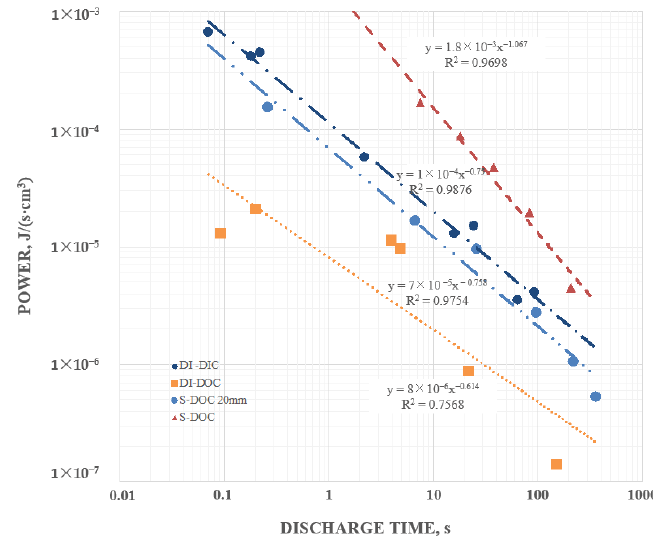
Figure 8. Increases with decreasing discharge time—the highest power, based on energy determined by integration over the full discharge, was found for S-DOC for the 6 mm capacitor and the lowest for the DI-DOC for the 6mm capacitor; however all configurations produced high power and showed the same trend with discharge time.